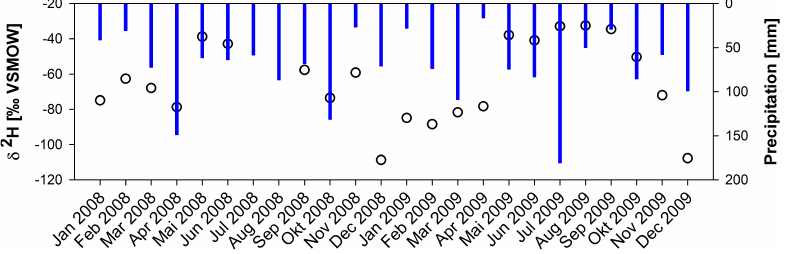
Fig. 5. Deuterium variability and monthly amounts of precipitation from January 2008 through December 2009 sampled about 10km north-west from the study hillslope.